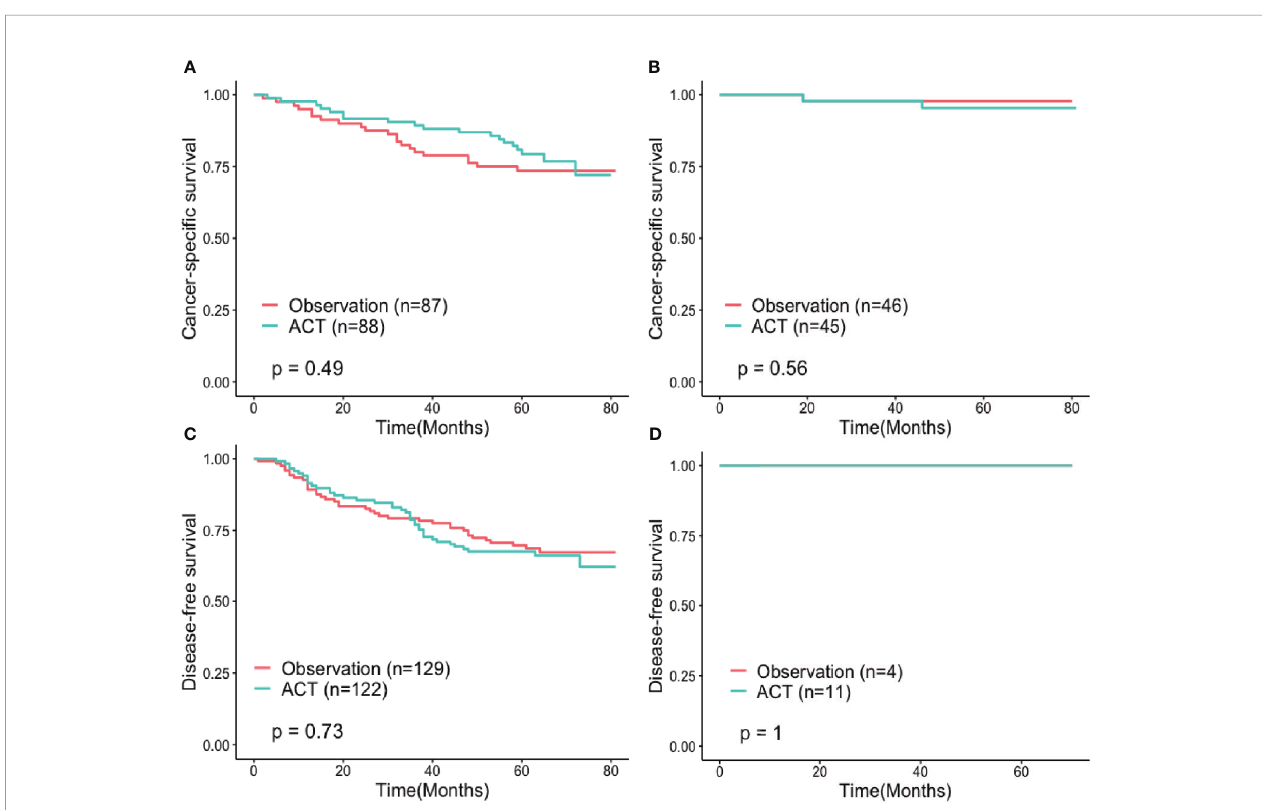
FIGURE 8 | Cancer-speci fi c survival of propensity score-matched (A) high-risk and (B) low-risk subgroups and disease-free survival of propensity score-matched (C) high-risk and (D) low-risk subgroups compared between patients treated with observation and adjuvant chemotherapy after surgery. ACT, Adjuvant